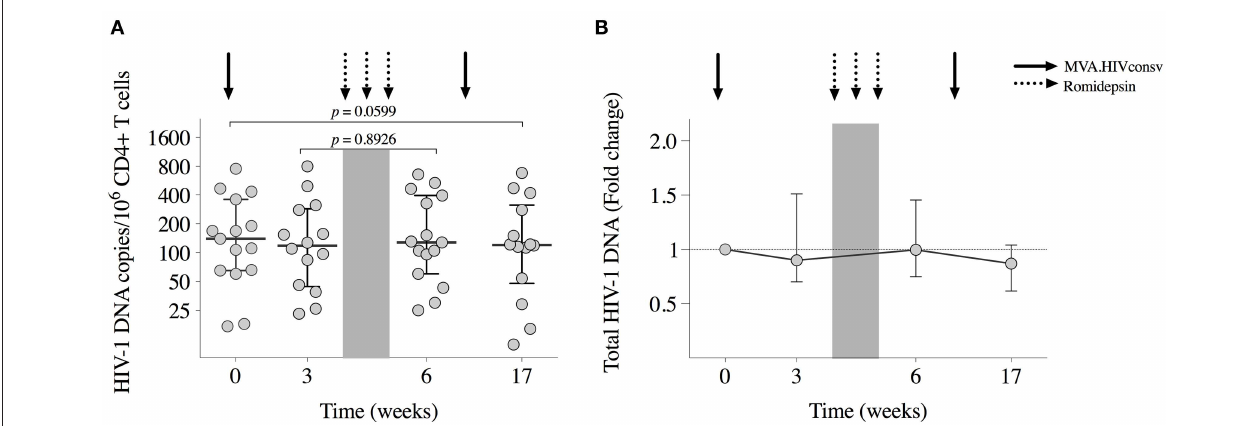
FIGURE 4 | Viral reservoir. (A) Total HIV-1 DNA copies/10 6 CD4 + T cells for each participant are shown at study entry (week 0), week 3 (day of RMD 1 ), and week 6 (1 week after RMD 3 ) and at week 17 (8 weeks after MVA 2 ). Horizontal and error bars represent median and IQR, respectively, and p -values correspond to comparisons between the indicated time points using the Wilcoxon signed-rank test. (B) Changes in proviral DNA throughout the study with respect to baseline (week 0), which is considered to be